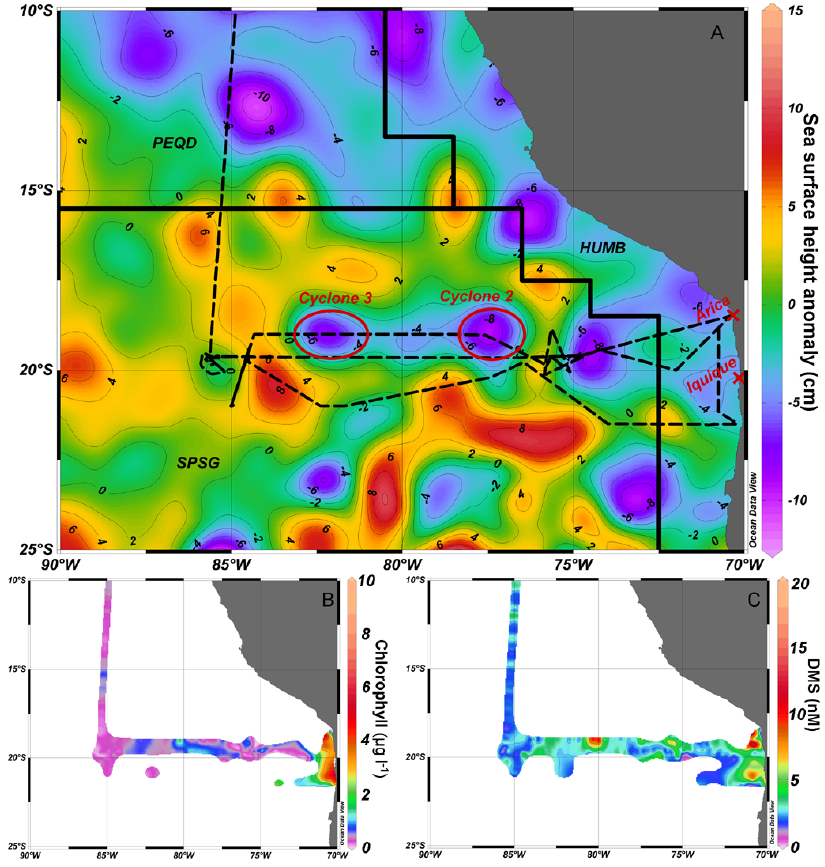
Fig. 1. The VOCALS REx study region. The ship travelled southbound from Panama to northern Chile (October–December 2008). The most northerly data reported in this paper are from ∼ 11.5 ◦ S. Panel A shows the cruise track (black dashed line), and the colouring in this Panel represents the mean sea surface height (SSH) anomaly (cm) for the week 1–7 October 2008 downloaded from the AVISO website (www.aviso.oceanobs.com). The second and third cyclones encountered are labelled and marked with red ellipses. The Longhurst (1995) biogeochemical provinces Pacific Equatorial Divergence (PEQD), South Pacific Subtropical Gyre (SPSG) and Humboldt Current Coastal Province (HUMB) and the Chilean communes of Arica and Iquique are shown to provide a spatial reference. Panels B and C show in situ chlorophyll (µgl − 1 ) and DMS (nM) respectively. These plots were produced using Ocean Data View (http://odv.awibremerhaven.de/home.